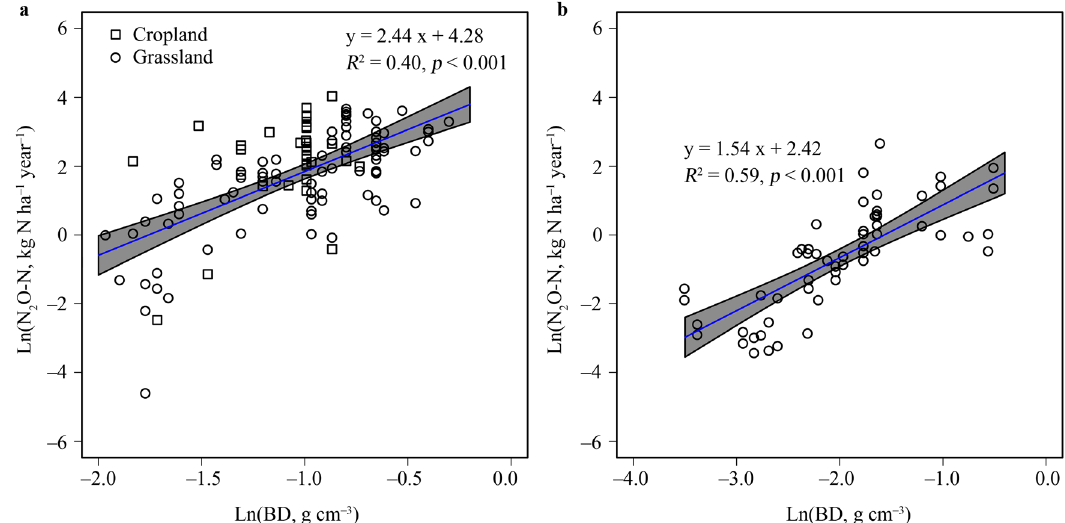
Fig. 4 The relationships between annual nitrous oxide (N 2 O-N) fl ux from peatlands and topsoil bulk density (BD). a Agricultural peatlands (cropland and grassland); b forested peatlands. Data are from Liu et al. 30 . The shaded areas indicate 95% con fi dence